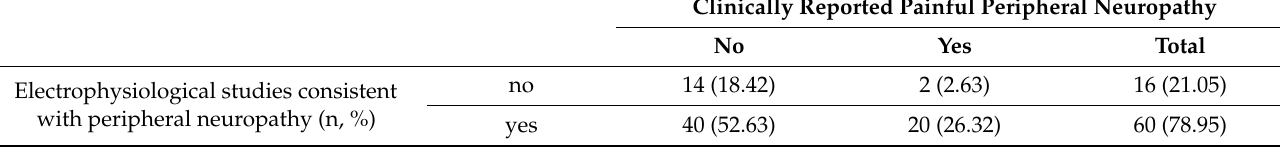
Table 2. The relationships between clinically reported peripheral neuropathy and presence of abnormalities in electrophysi- ological examination.